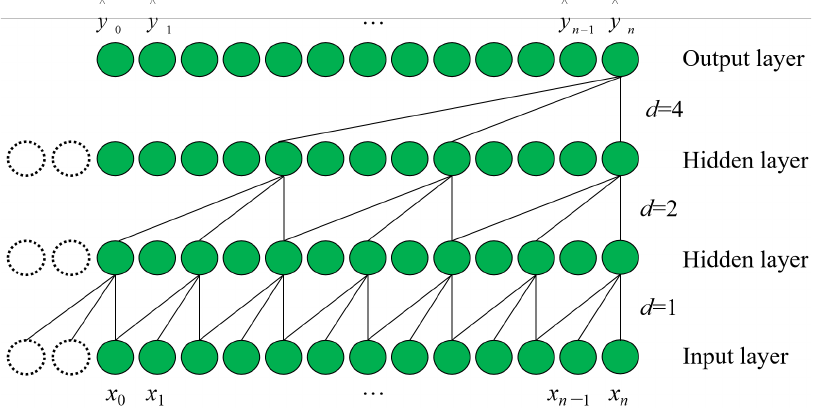
Figure 1. Dilated Causal Convolution kernel.